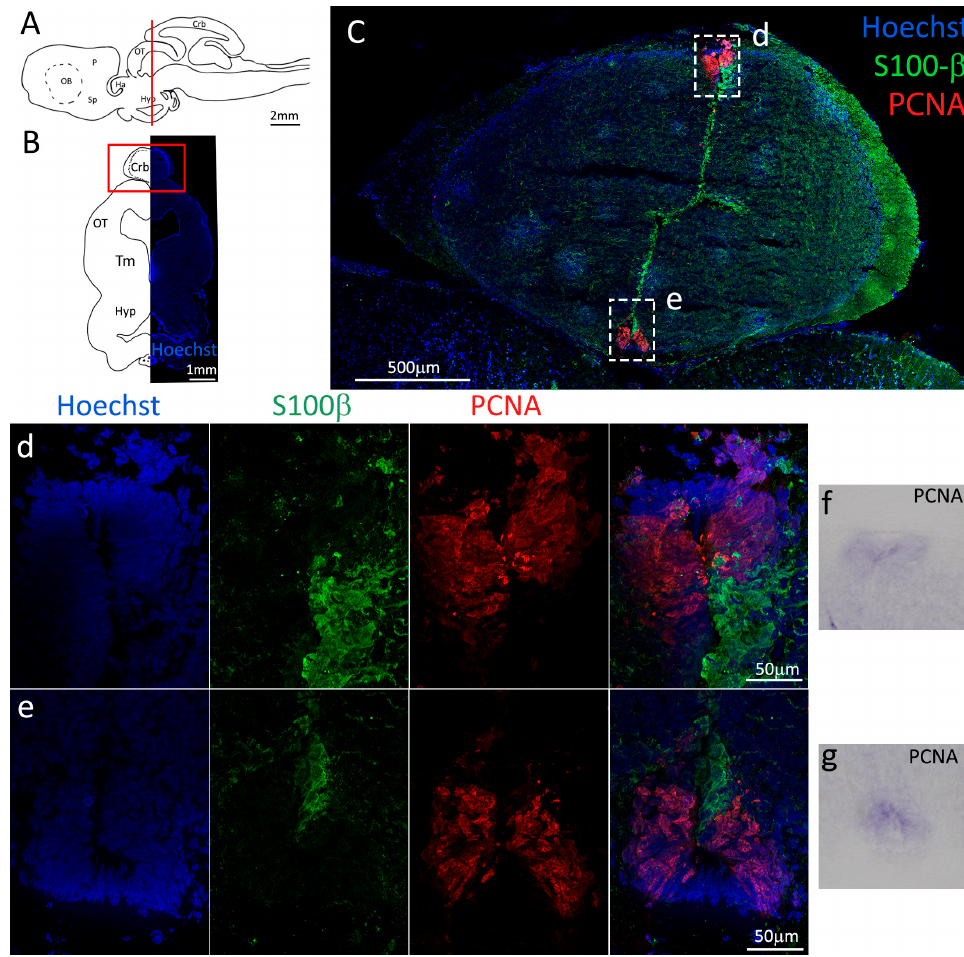
Figure 13. Localization of PCNA (red) and S100 β (green) positive cells in the anterior cerebellum of S. canicula . ( A ) Sagittal representation of S. canicula brain. The red line indicates the rostro-caudal localization of the section represented in the panel. ( B ) Coronal map of the area imaged. On the right, a real coronal section is stained with Hoechst 33342 to show nuclei distribution; on the left, a cartoon is drawn to indicate anatomical references. Red rectangle identifies the general area from which images are taken. ( C ) Neurogenic niches of the anterior cerebellum. All PCNA + cells (red) appear to be S100 β − , suggesting a neuroepithelial origin of the stem cells. ( d ) Magnification of the neurogenic niche localized in the dorsal cerebellum. ( e ) Magnification of the neurogenic niche localized in the ventral cerebellum. ( f , g ) In situ hybridization for S. canicula pcna in dorsal and